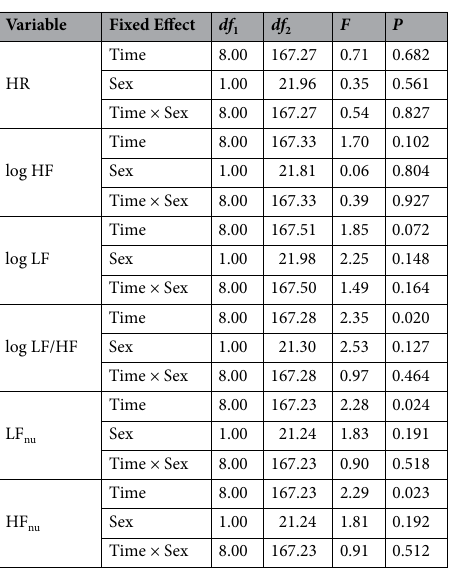
Table 2. Mixed models investigating the effects of expedition duration and sex on heart rate and indices of cardiac autonomic modulation. Note: Mixed models were run with time and sex as fixed effects, baseline as a covariate, and participants as a random factor (random intercept only); df 1 , numerator degrees of freedom; df 2 , denominator degrees of freedom; F , F-statistic; P , p